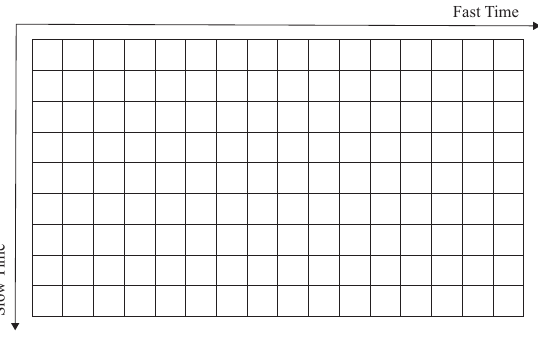
Figure 4. Slow Time and Fast Time Matrix.